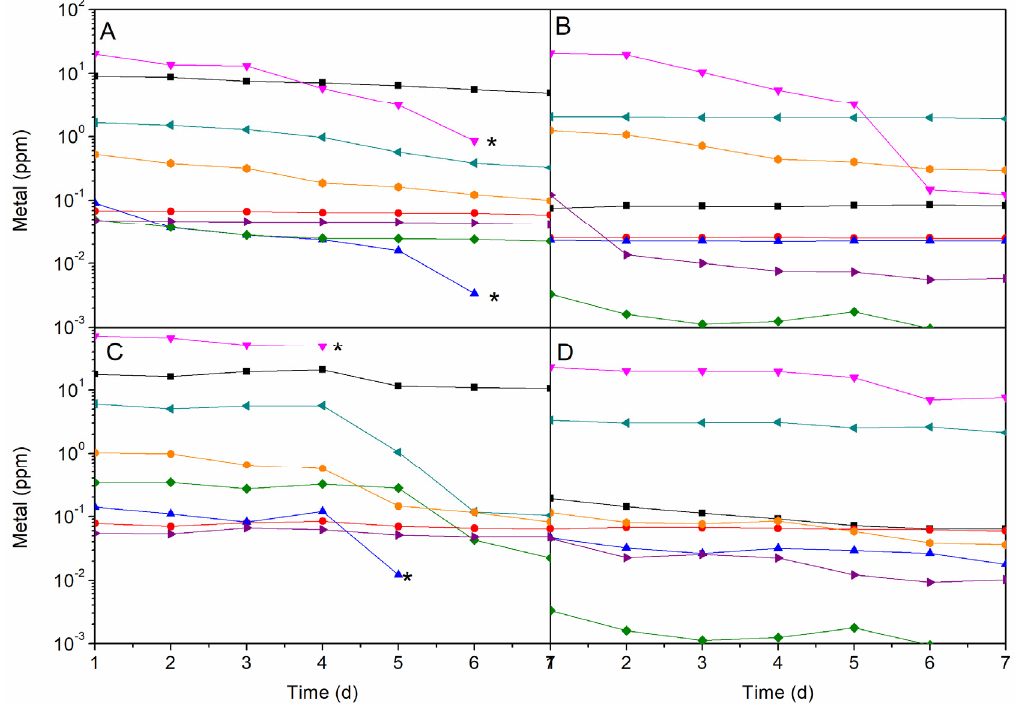
Figure 5. Trace element concentration in the culture media during optimum growth of A. maxima in MC1 ( A ), C. vulgaris in MC4 ( B ), I. galbana MC3 ( C ) and N. gaditana in MC4 ( D ) ( ■ B, ● Co, ▲ Cu, ▼